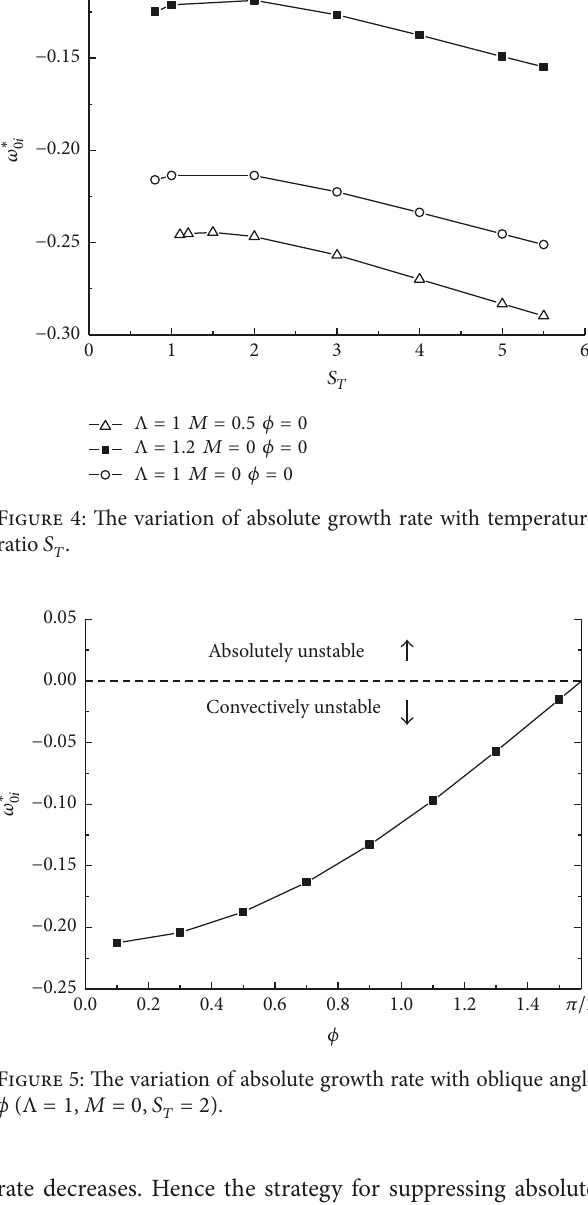
rate decreases. Hence the strategy for suppressing absolute instability is to increase temperature